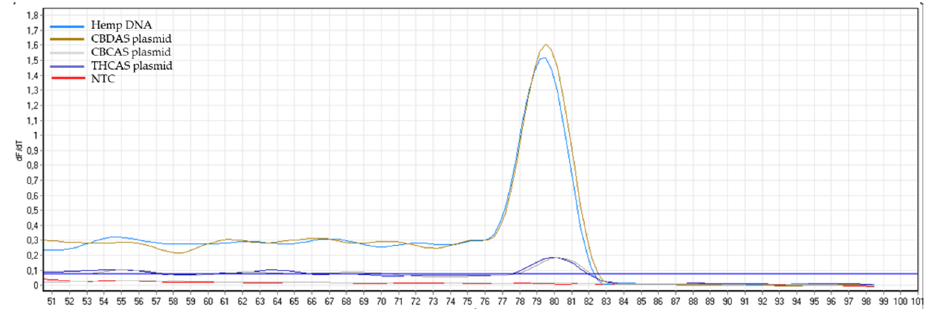
signal for negative controls (in both cases the controls are represented by plasmids with a